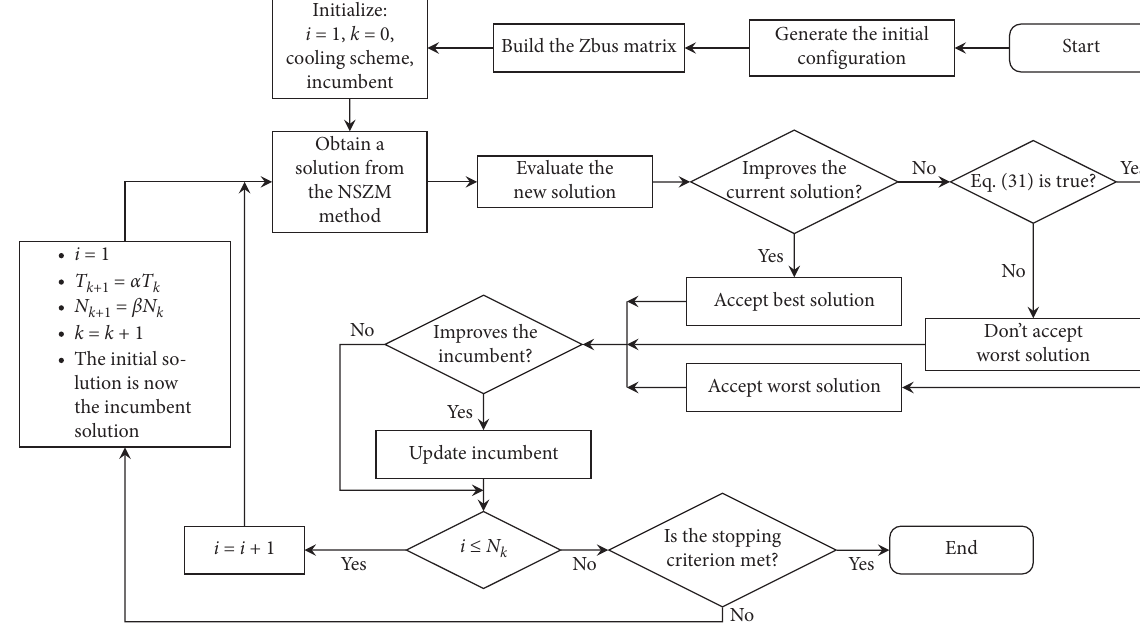
Figure 3: Flowchart of the SA-NSZM.